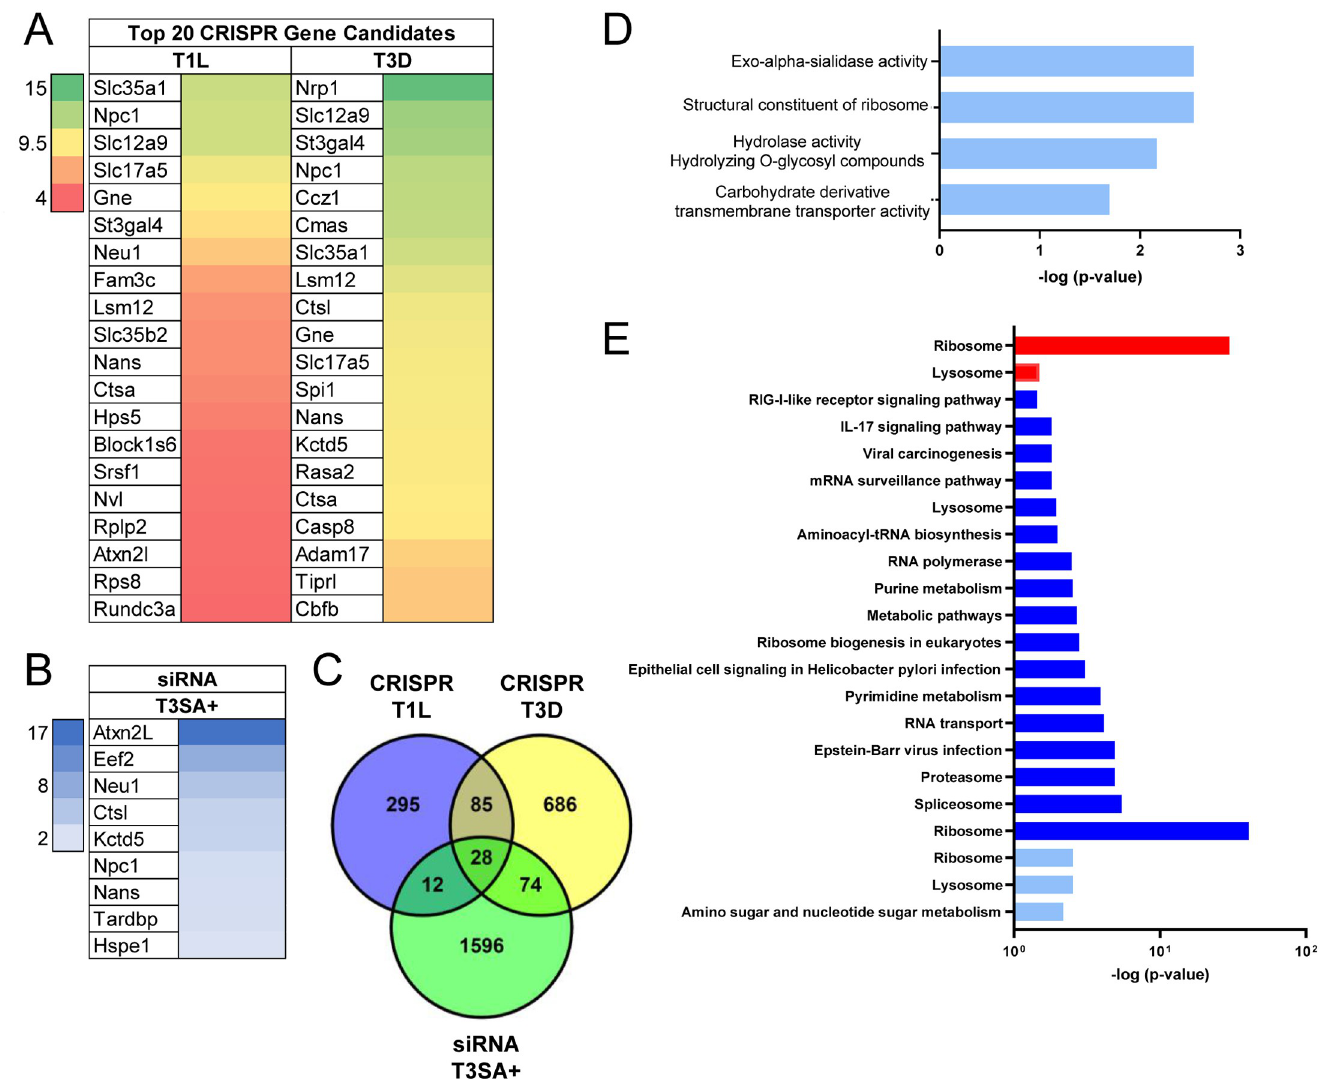
Fig 1. CRISPR and siRNA screens identify NPC1 as a cellular factor required for reovirus infection. (A) The top 20 candidates from the CRISPR screen using reovirus strains T1L and T3D are ranked by their STAR scores. Heat map indicates STAR values. (B) Genes from the siRNA screen using reovirus strain T3SA+ common to the CRISPR screen using T1L and T3D, excluding ribosomal genes. Heat map indicates z-score values. (C) Venn diagram of genes from the CRISPR screens using T1L and T3D and the siRNA screen using T3SA+. (D) Molecular function pathways using Gene Ontology to analyze genes from the CRISPR screen common to T1L and T3D. (E) KEGG pathways identified for the CRISPR screen using T1L (red) and T3D (blue) and siRNA screen using T3SA+ (light